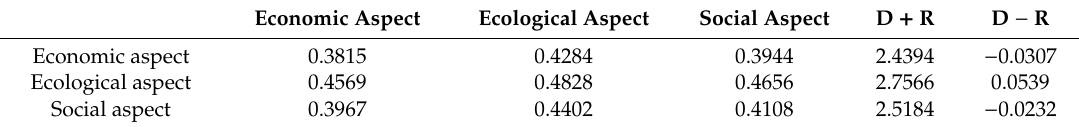
Table 2. DEMATEL results for the ecological park.